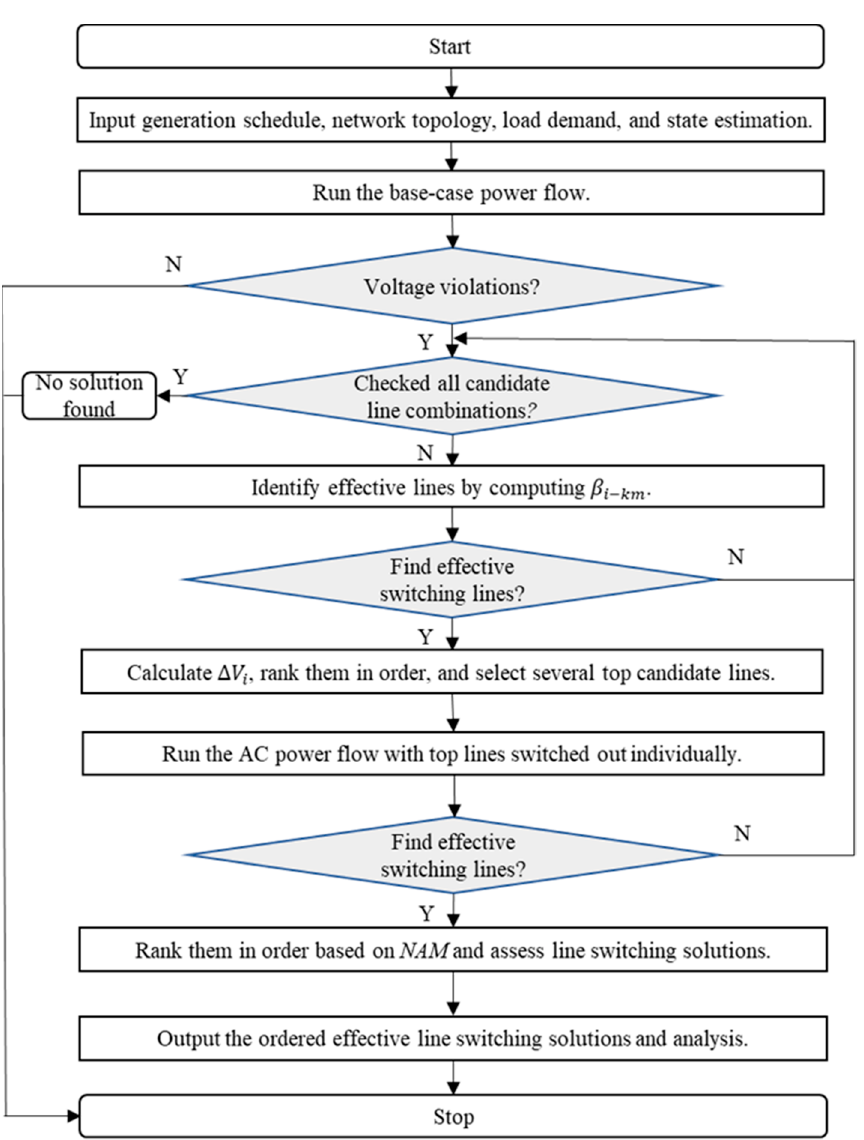
Figure 7. Flow chart of the proposed methodology.